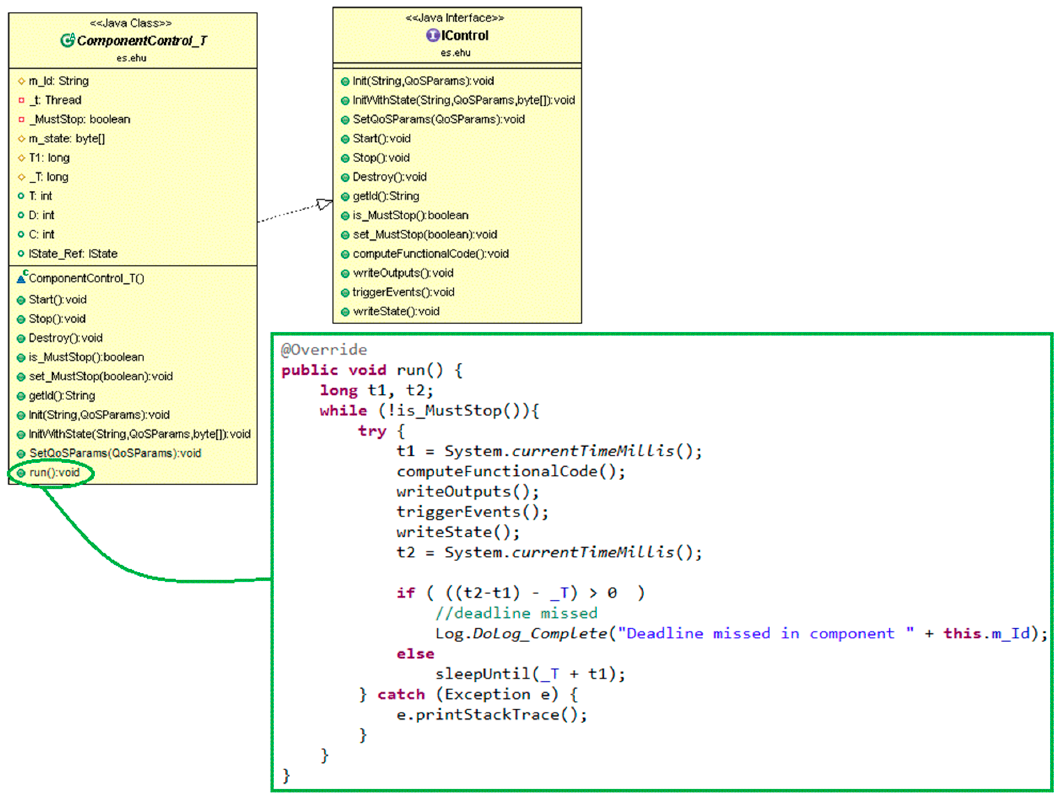
Figure 4 . Base class for periodic application components. Figure 4. Base class for periodic application